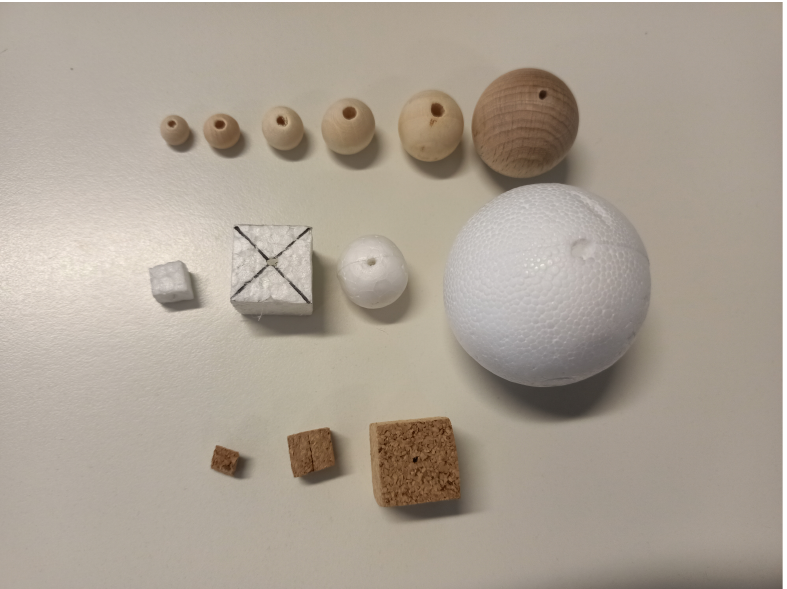
Figure 4. Picture of the objects adopted for the measurement campaign. From the top row: circular wooden spheres of different size, styrofoam cubes and spheres, cork cubes. Table 1. Features of the objects involved in the measurement campaign.